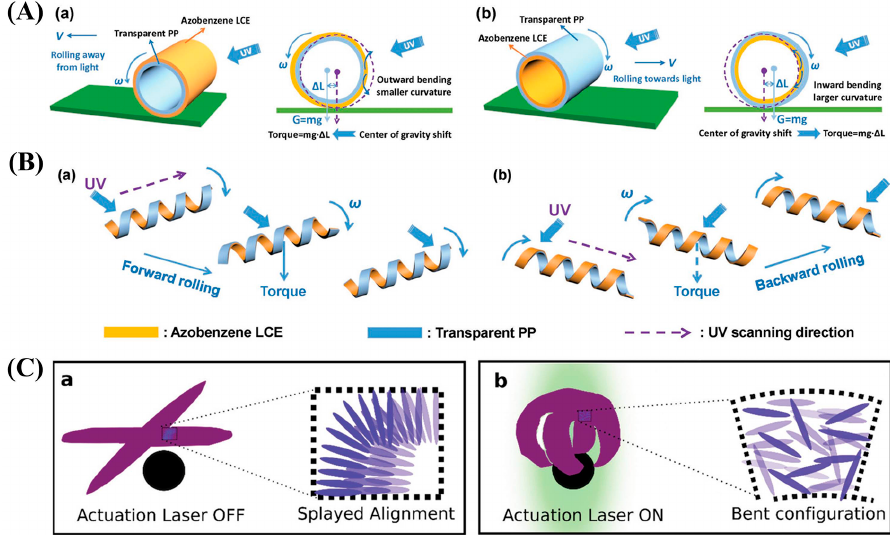
Figure 3. Light-controlled motion of liquid crystalline polymer. ( A ) Schematic showing (a) leftward and (b) rightward shift of the center of gravity in the wheel due to the UV-light-induced asymmetric deformation. Reproduced with permission [77]. Copyright 2017, WILEY-VCH; ( B ) Schematic of light-pushing forward rolling (a) and light-pulling backward rolling (b) of the helical ribbons due to UV-light-induced torque. Reproduced with permission [77]. Copyright 2017, WILEY-VCH; ( C ) Schematic of photonic microhand design (a) Illustration of a microhand and related mesogen alignment. (b) Illustration of the closed microfingers in response to an optical stimulus and the related change in molecular alignment. Reproduced with permission [87]. Copyright 2017, WILEY-VCH.